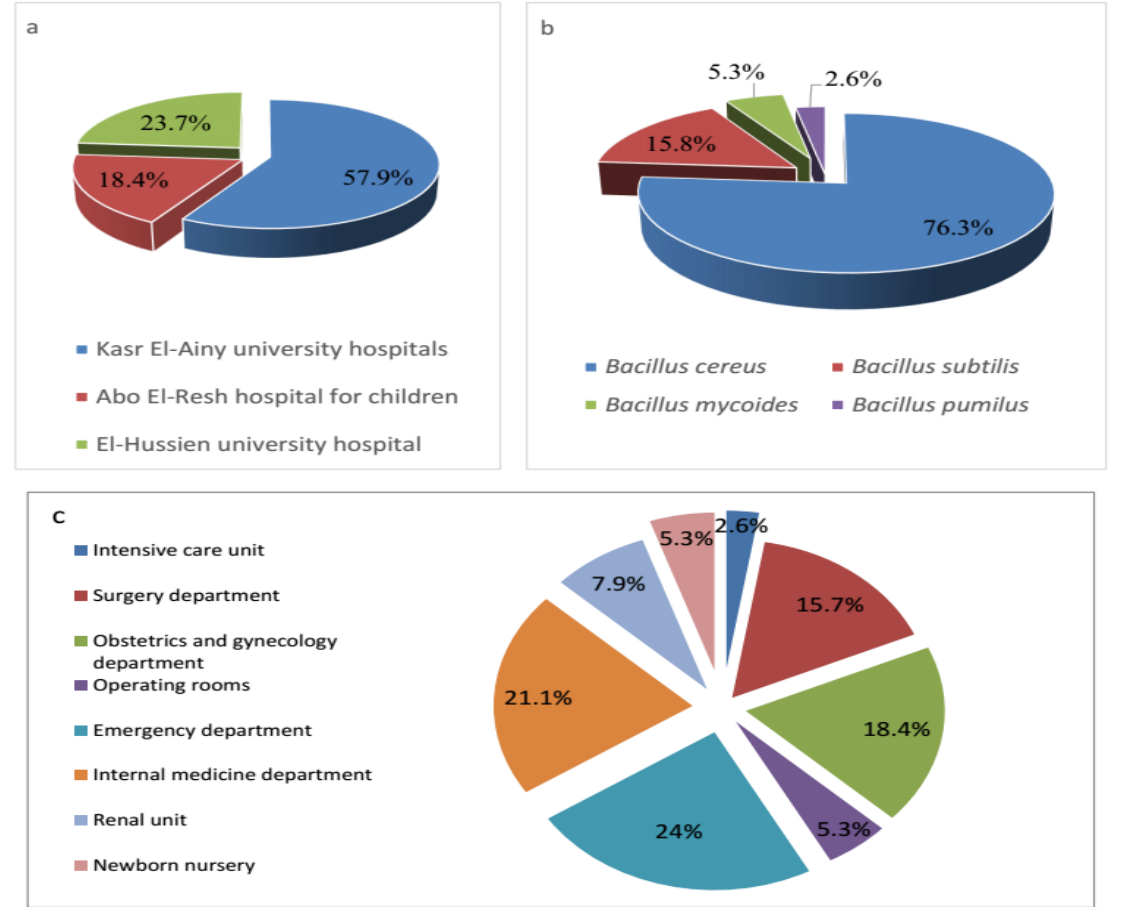
Figure 2. Prevalence of MDR of Bacillus isolates: a, regarding study hospitals; b, regarding species and c, regarding sampling site.